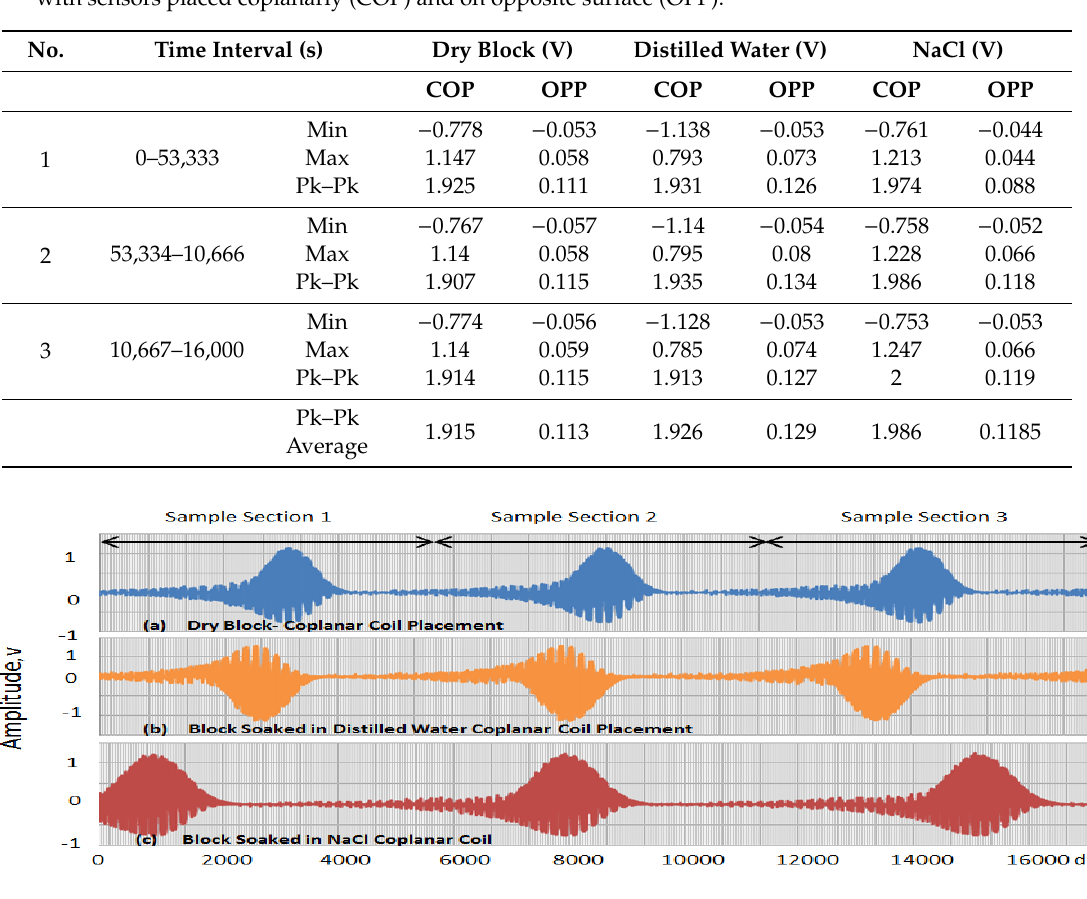
Figure 6. Graphs of signals (voltages) obtained from tests conducted with coplanar-placed sensors on ( a ) dry block, ( b ) concrete block submerged in distilled water and ( c ) concrete block submerged in NaCl solution .